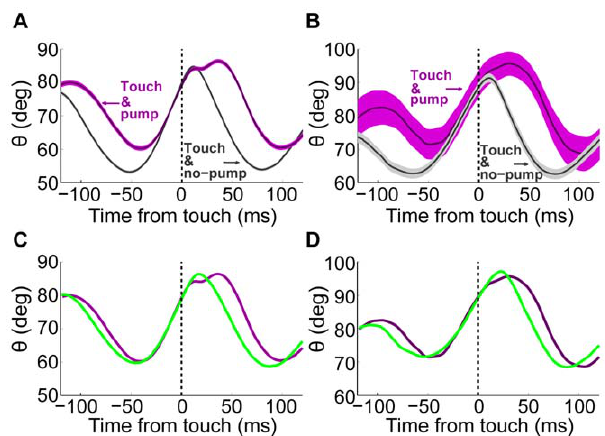
Figure 5. TIPs occur more often in whisk cycles with higher set- points. A. The average angle trace of whisker C1 (not touching) triggered on the onset of touch by whisker C2 for all whisks with (purple; mean 6 SE) and without pumps (grey; mean 6 SE). B. Similar to A, but when only data from the first touches in a trial (N=140) were used. C. Mean trace around touch with TIP (purple) and over a subset of traces around touch with no TIP (control; green) for the data in A. The control subset was chosen by removing traces with the lowest set points, so that the mean set points of the control (green) and pump (purple) traces will be equal. D. Similar to C, but when only data from the first touch occurring in a trial was used.